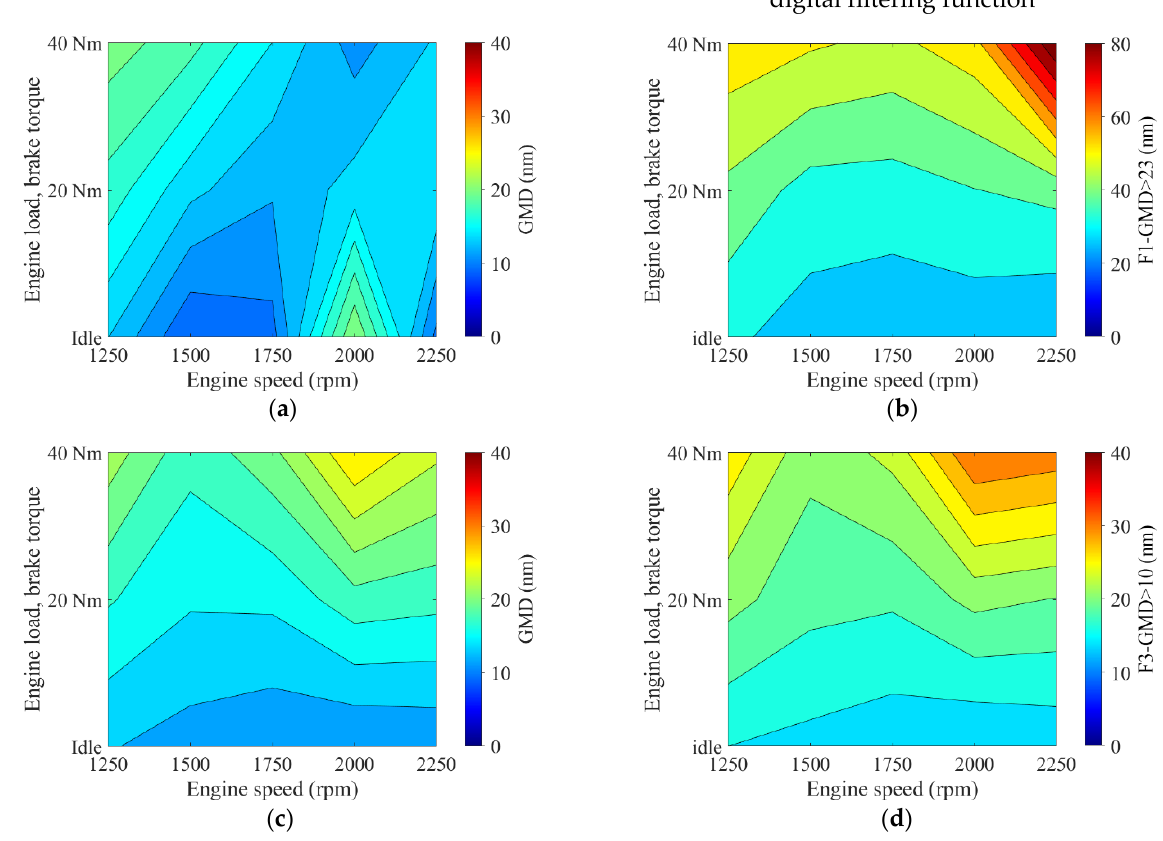
Figure 6. Geometric mean diameter (GMD) by engine speed and load for DMS measurements with and without catalytic stripper (CS) in subfigures ( c , d ) and ( a , b ), respectively. The data displayed in subfigures ( a , c ) has been particle loss corrected. The data displayed in subfigures ( b , d ) has been digitally filtered in addition to the particle loss correction. For the digital filtering, Equation (1) was applied for F1-GMD > 23 and Equation (3) for F3-GMD >